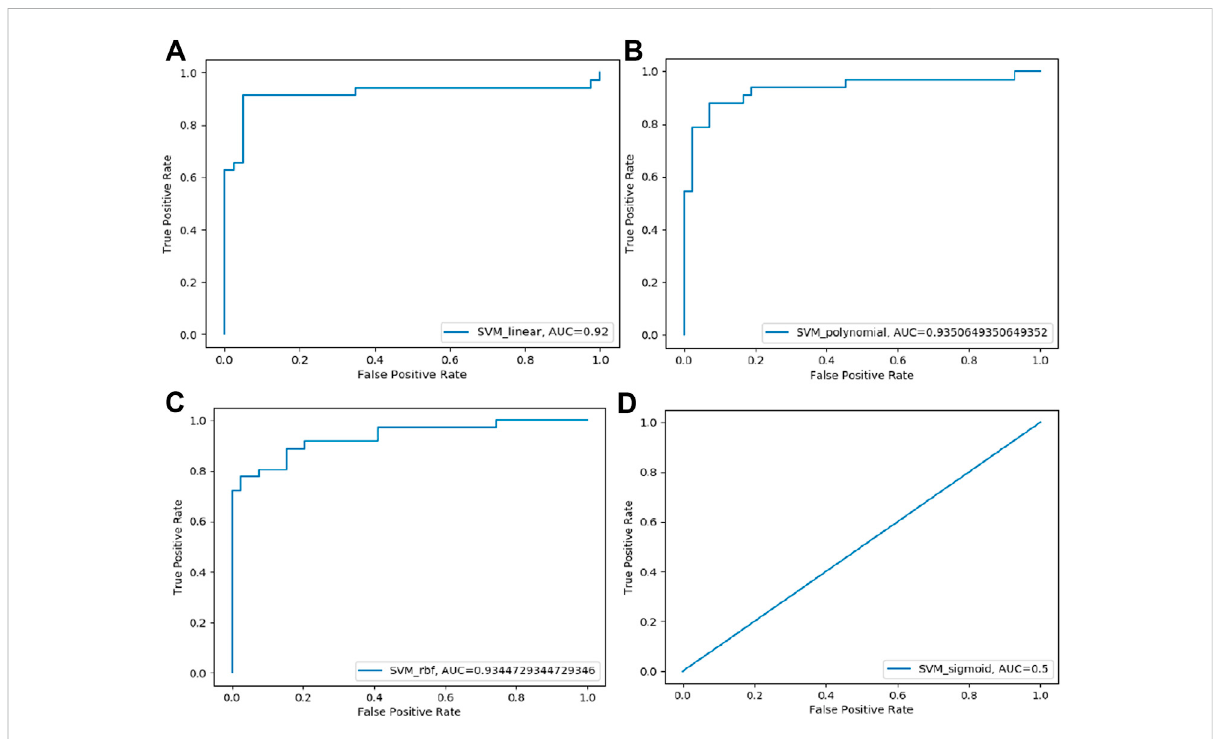
FIGURE 4 ROCcurveoffourSVMmodelsperformancebasedonAUCscore: (A) SVM-LinearmodelROCcurve (B) SVM-PolynomialmodelROCcurve (C) SVM-rbf model ROC curve (D) SVM-Sigmoid model ROC curve.